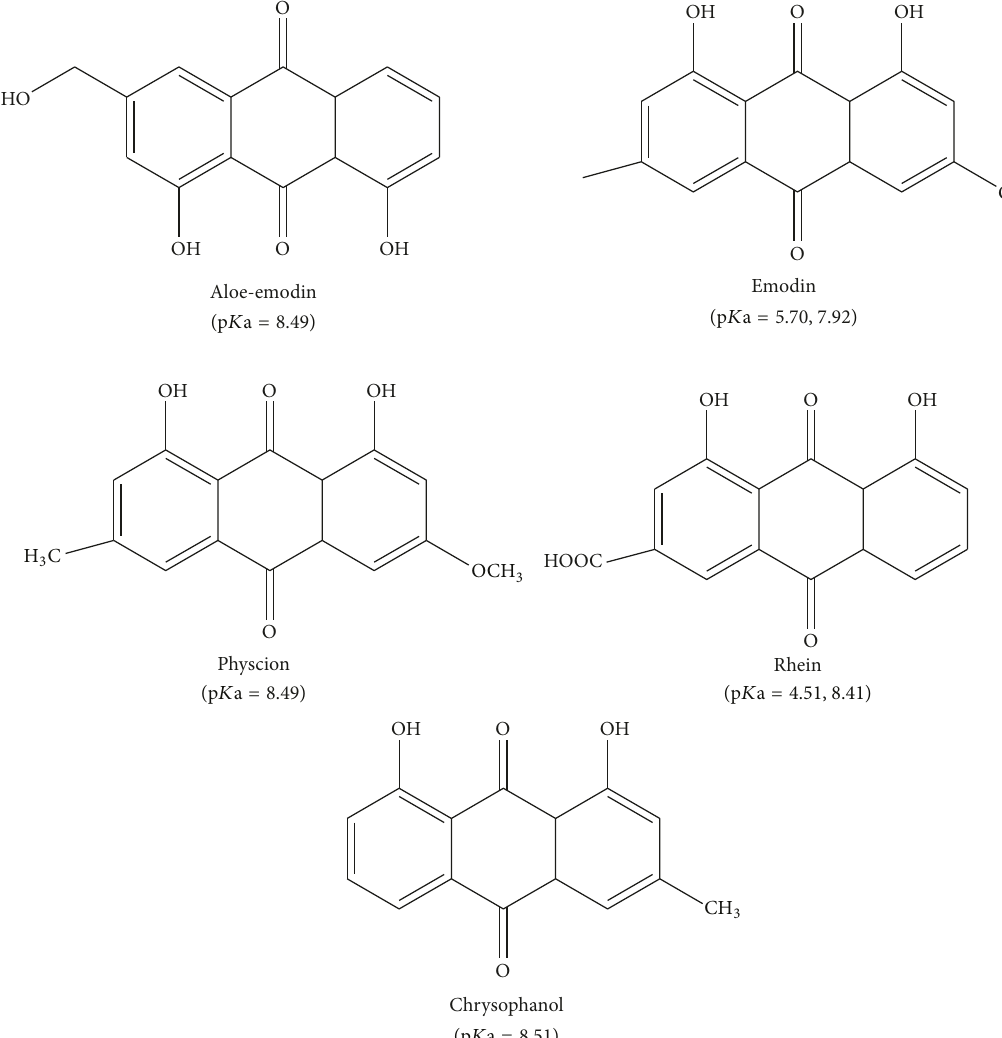
Figure 1: The chemical structures and p 𝐾 a values of the studied